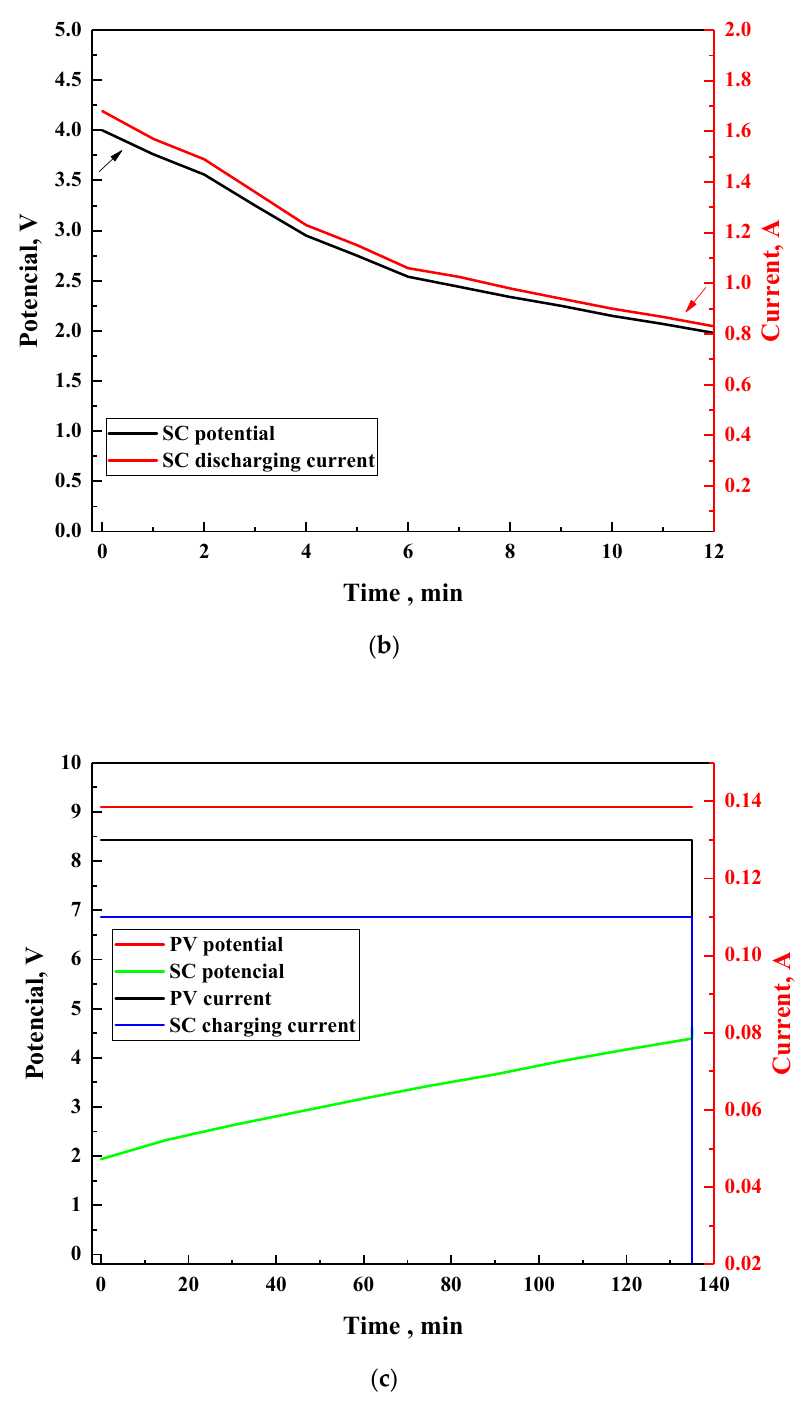
Figure 7. Characteristics of demonstrator no. 1 under charging supercapacitors to V Cw ( a ), under discharge of supercapacitors to V = 2 V ( b ), and under second charging supercapacitors to V Cw after three months ( c ).